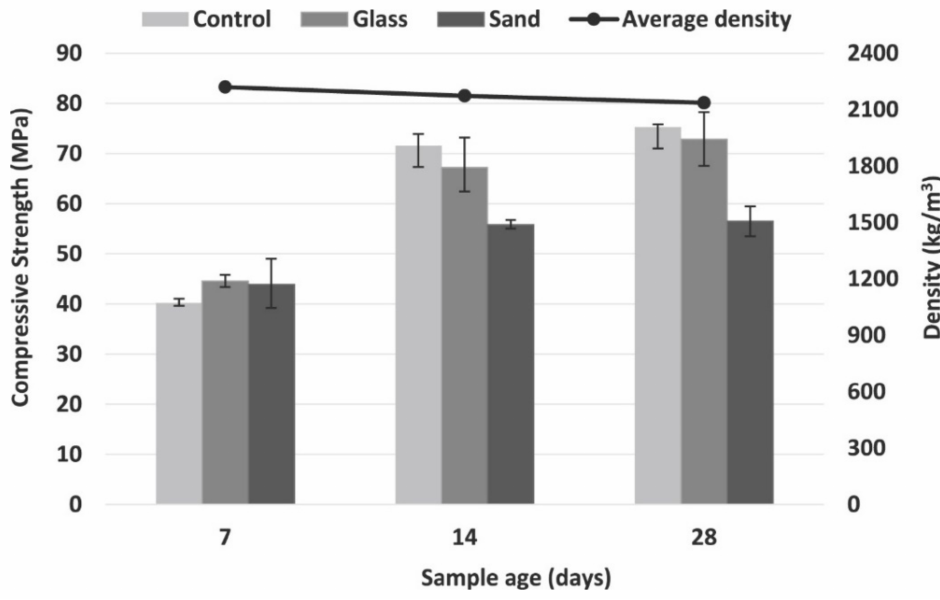
Figure 25. Density of geopolymer concretes with different aggregates at different ages [35].